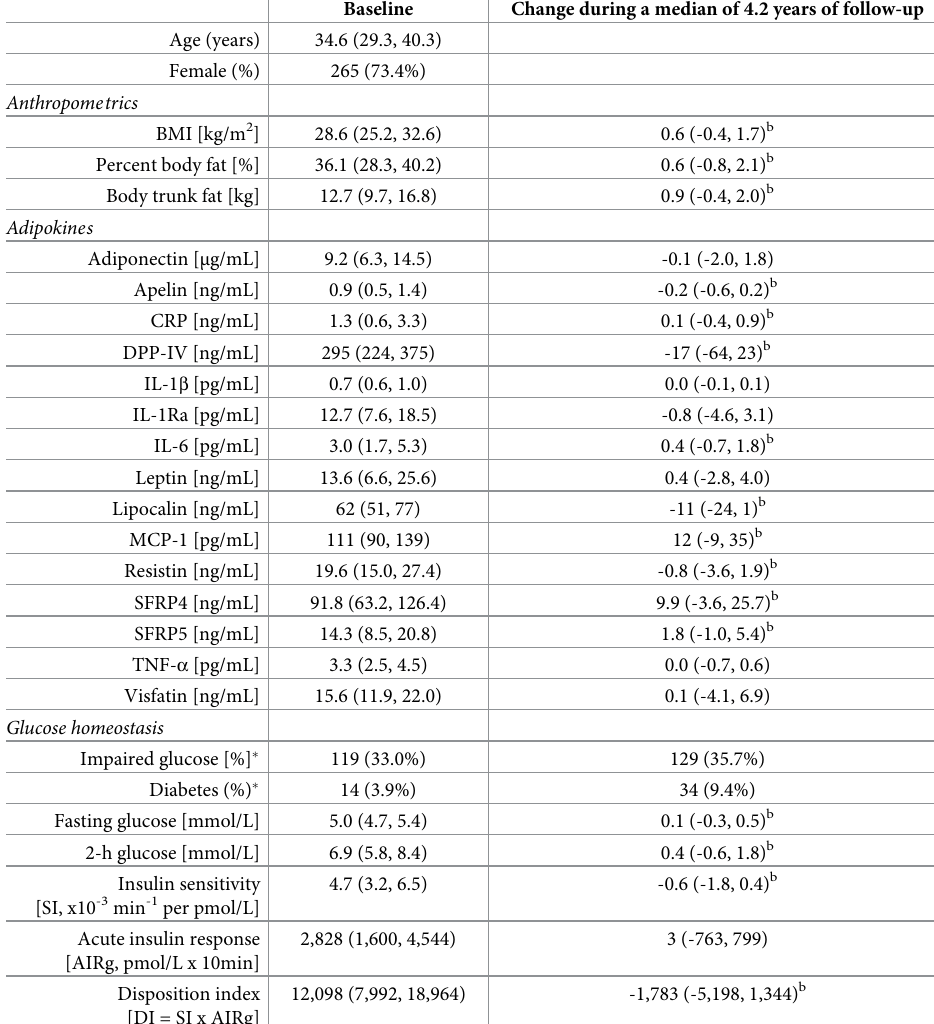
Table 1. Baseline and follow-up characteristics (n = 361) a